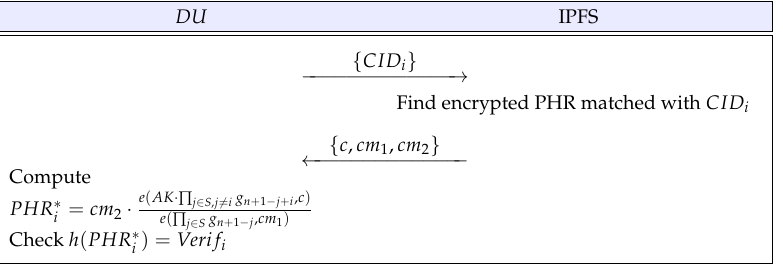
Figure 5. Data request